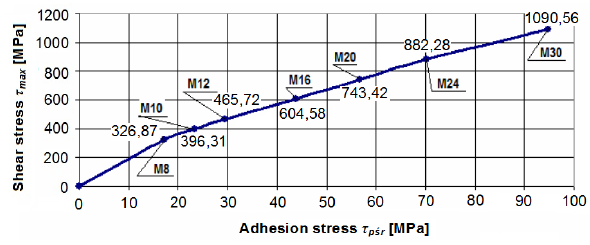
Figure 17: Dependency edge stress – adhesion stress for diagonal anchors.